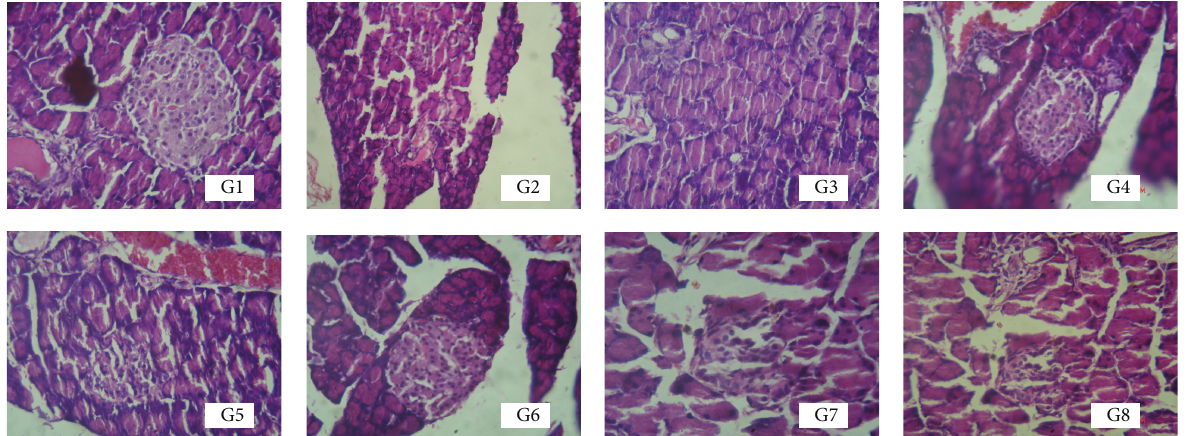
Figure 9: Histopathology of rat pancreas (40x); G1: normal control; G2: diabetic control (nicotinamide + STZ); G3: diabetic + glibenclamide (2.5 mg/kg); G4: diabetic + quercetin (10mg/kg); G5: diabetic + JY-1; G6: diabetic + JY-2; G7: diabetic + JY-3; and G8: diabetic + JY-4; (all test compounds at optimised dose of